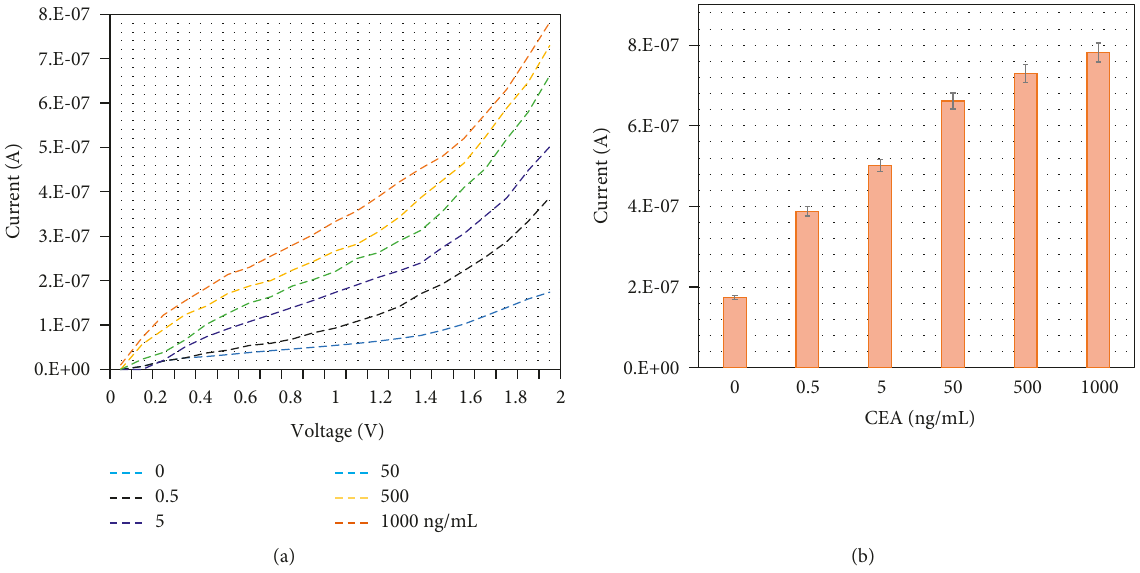
Figure 4: (a) CEA identification by sandwich assay with aptamer. Various concentrations of CEA were diluted in PBS and drop cast onto the anti-CEA aptamer-constructed electrode surface, and then, a fixed concentration of detection aptamer was added. A clear increase in the response was recorded for each CEA concentration. (b) Electrochemical response for CEA identification. The electrochemical response is increased by increasing the CEA concentration. The averaged values obtained from the replicates are displayed by the error bars.